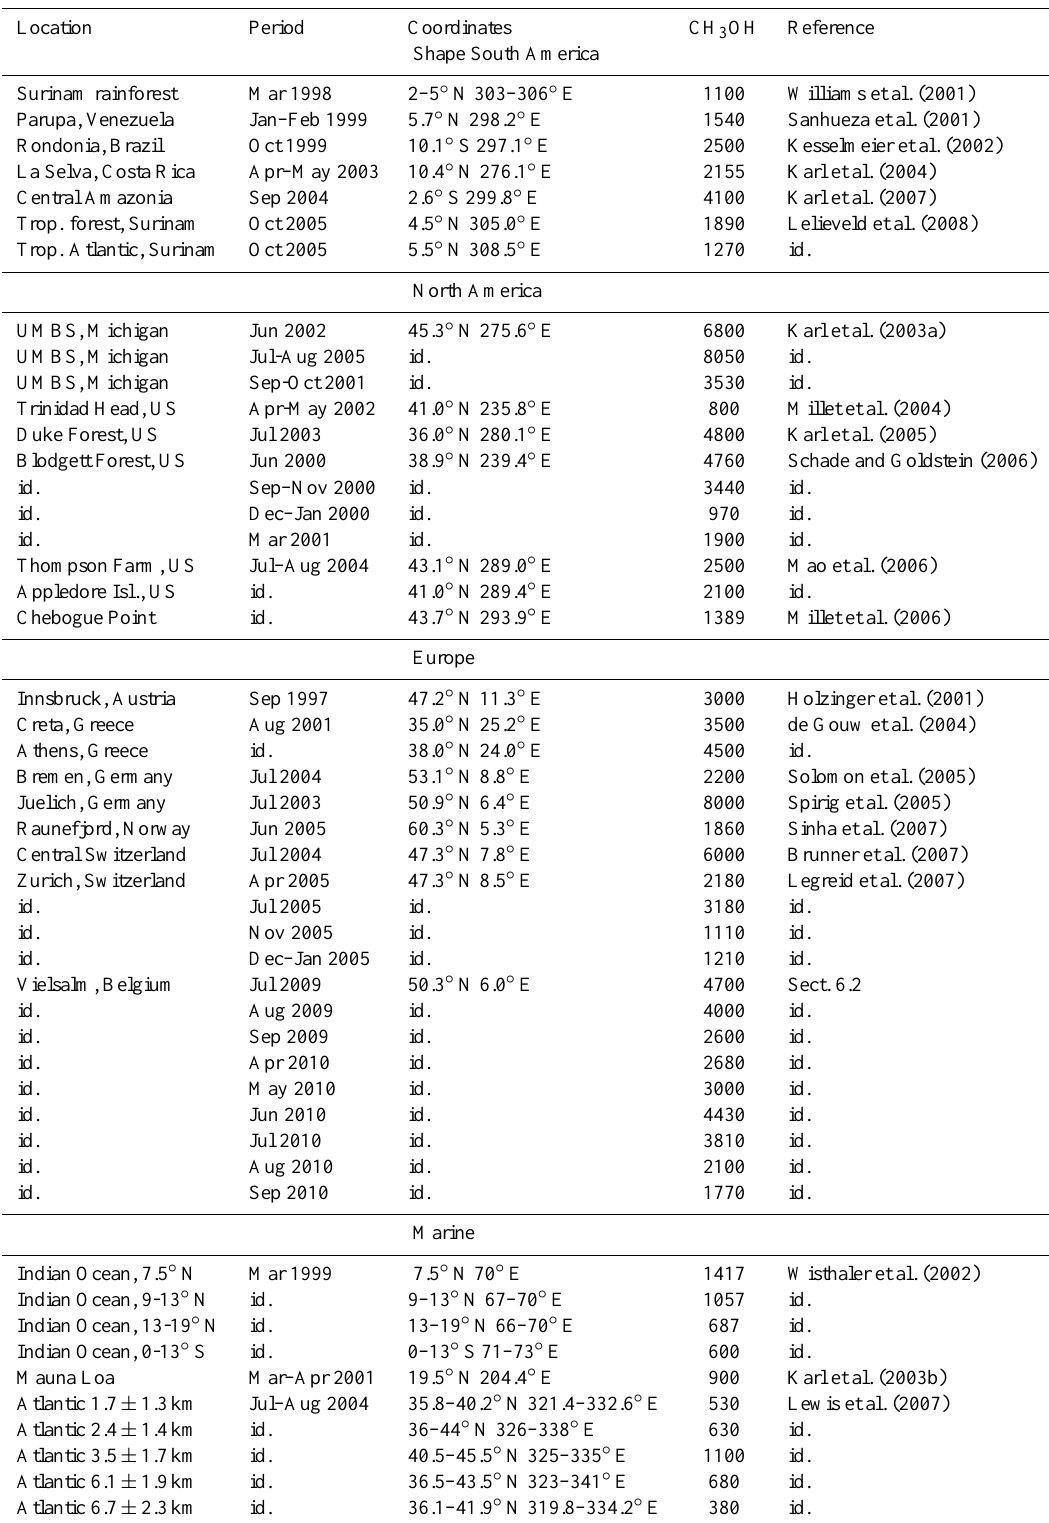
Table 5. In situ methanol measurements expressed in